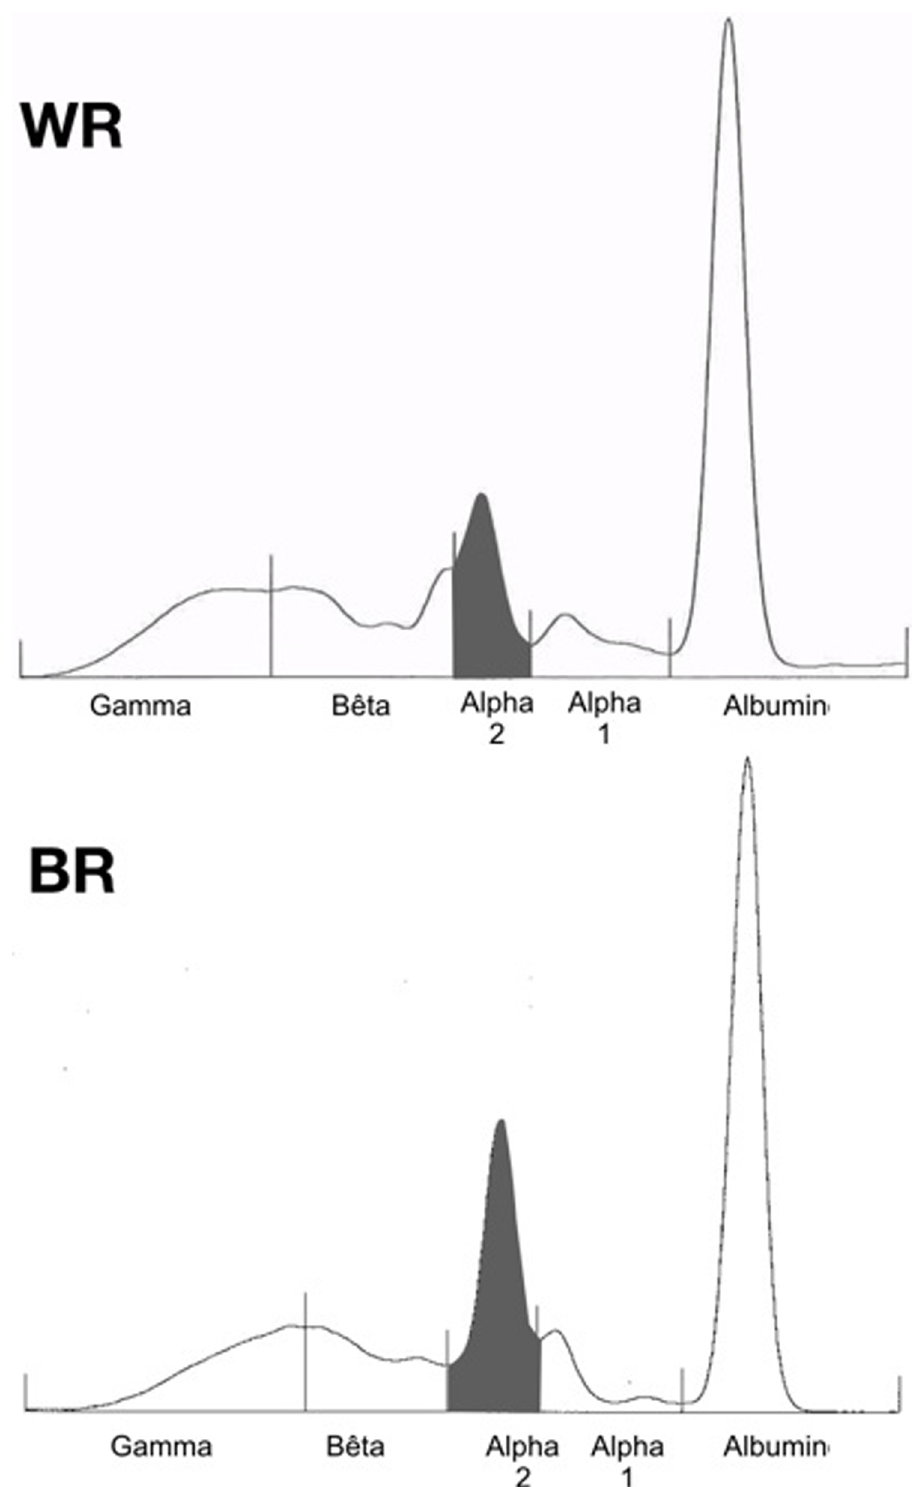
Fig 2. Serum protein electrophoreses showing an example of the serum protein distribution in a black rhinoceros (BR, total proteins 92 g/L, α 2 globulins 27 g/L) and a white rhinoceros (WR, total proteins 75 g/L, α 2 globulins 9.6 g/L). Note the increased size of the α 2 globulin region in the BR compared to the WR (grey areas).